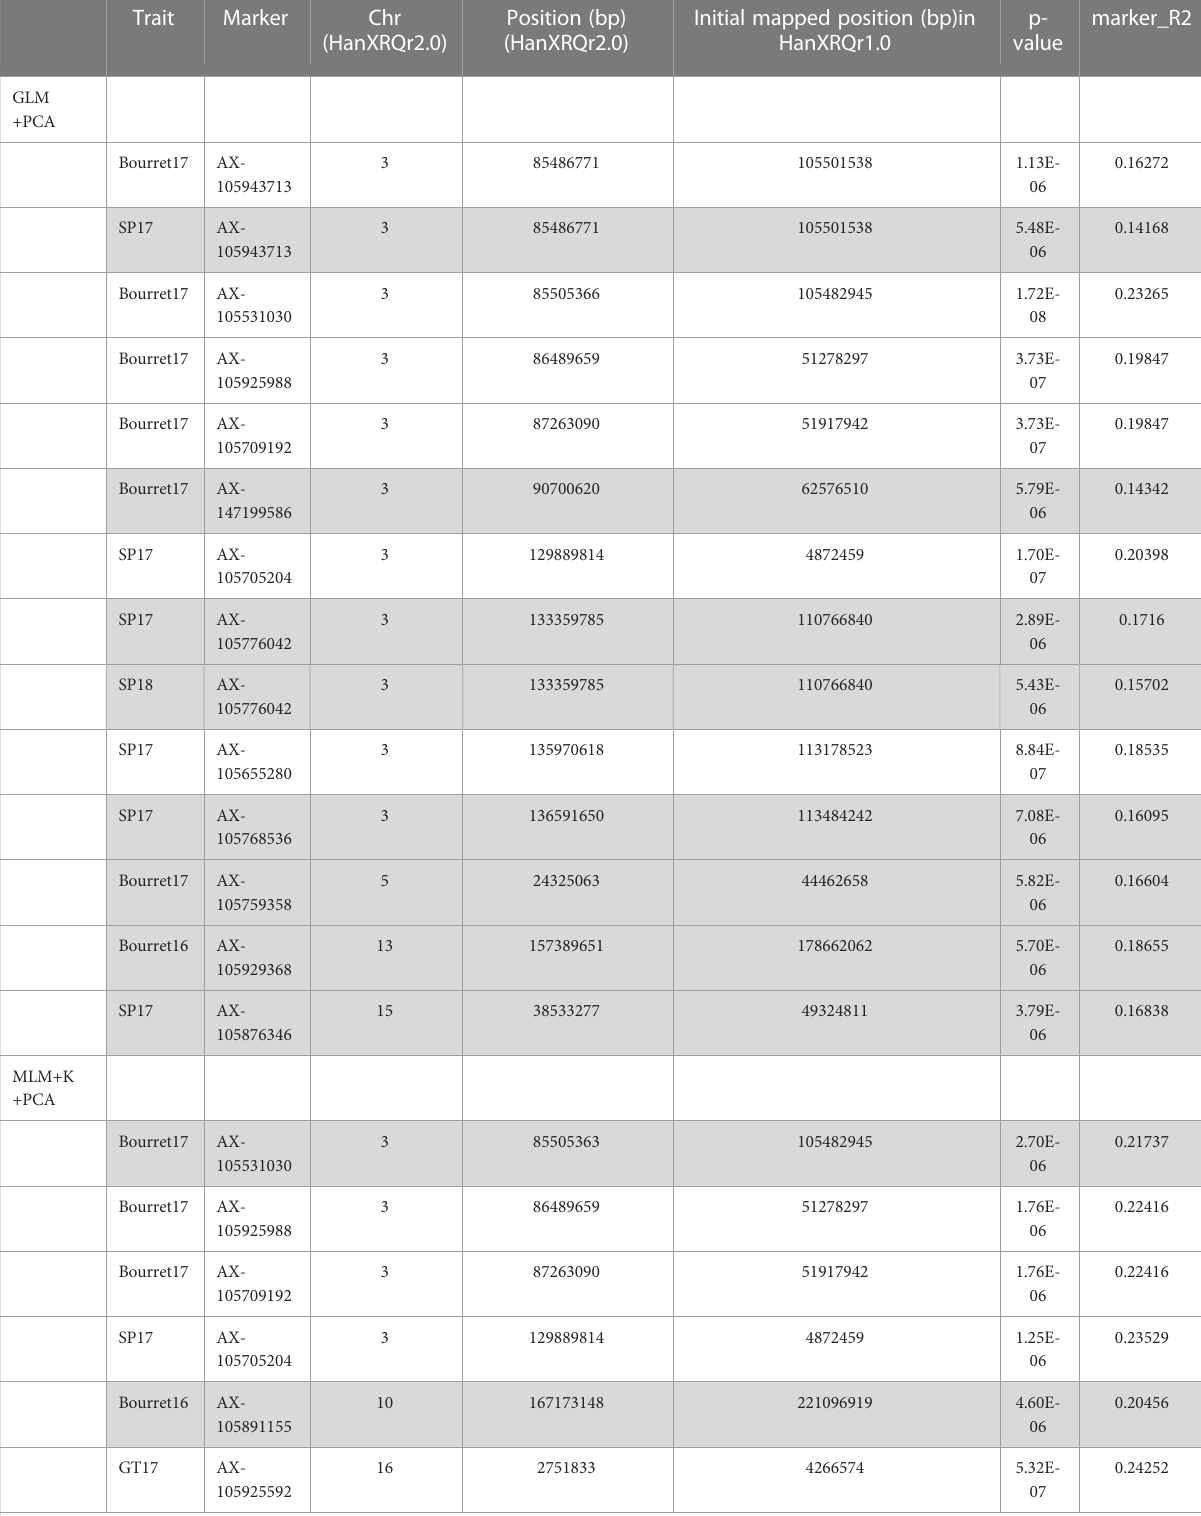
Unshaded data corresponds to the markers that exceed Bonferroni 5% threshold and shaded markers corresponds with Bonferroni